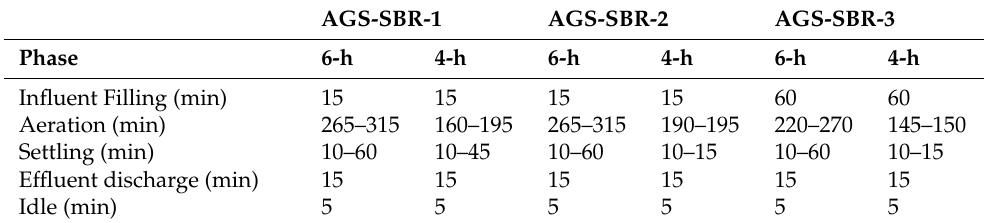
Table 1. Cycle time and sequential phases for the investigated AGS-SBRs.